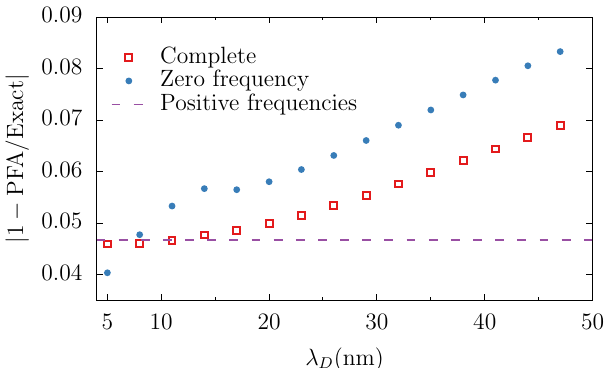
Figure 5. Relative discrepancy between the PFA and the exact result as a function of the Debye length for the total free energy (red squares) and the zero-frequency contribution F cas horizontal dashed line indicates the discrepancy when considering positive frequencies only, which do not depend on λ D . We consider two PS spheres of radius 1 µ m separated by a distance of